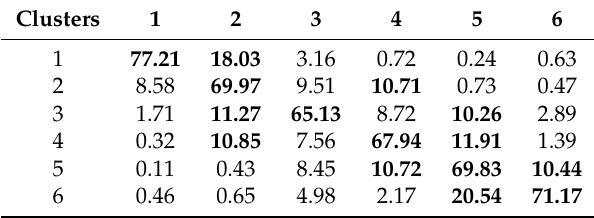
Table 4. Table of transition probabilities between clusters from a month to another.